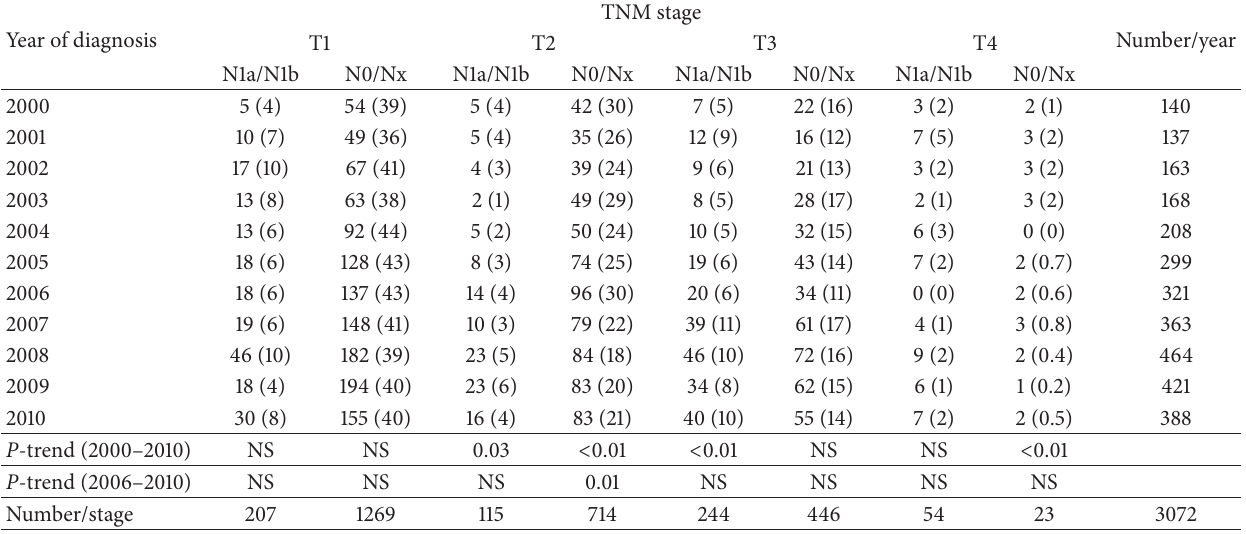
Table 2: Patients with well-differentiated thyroid cancer over time (all centers combined).